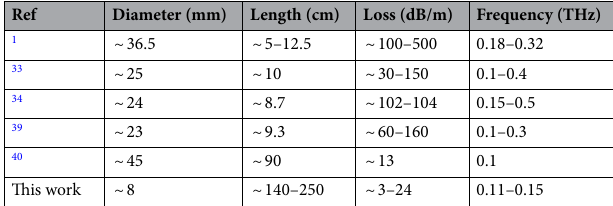
Table 1. Comparison of FDM-based 3D printed THz